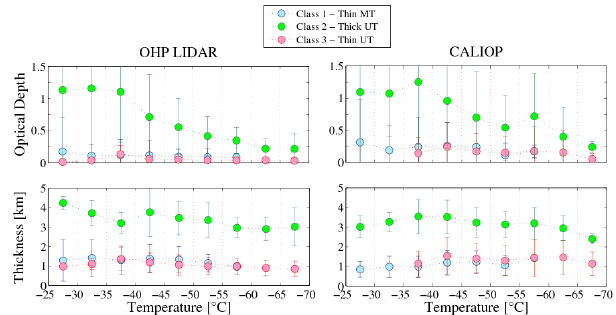
Fig. 11. Average optical depth (top) and geometrical thickness (bot- Figure 11. Average optical depth (top) and geometrical thickness (bottom) in 5°C intervals of 2 tom) in 5 ◦ C intervals of mid-cloud temperature for each cirrus mid-cloud temperature for each cirrus clouds class. Panels on the left correspond to the 3 clouds class. Panels on the left correspond to the analysis performed analysis performed from OHP lidar data and panels on the right correspond to those 4 from OHP lidar data and panels on the right correspond to those per- performed from CALIOP. 5 formed from CALIOP.